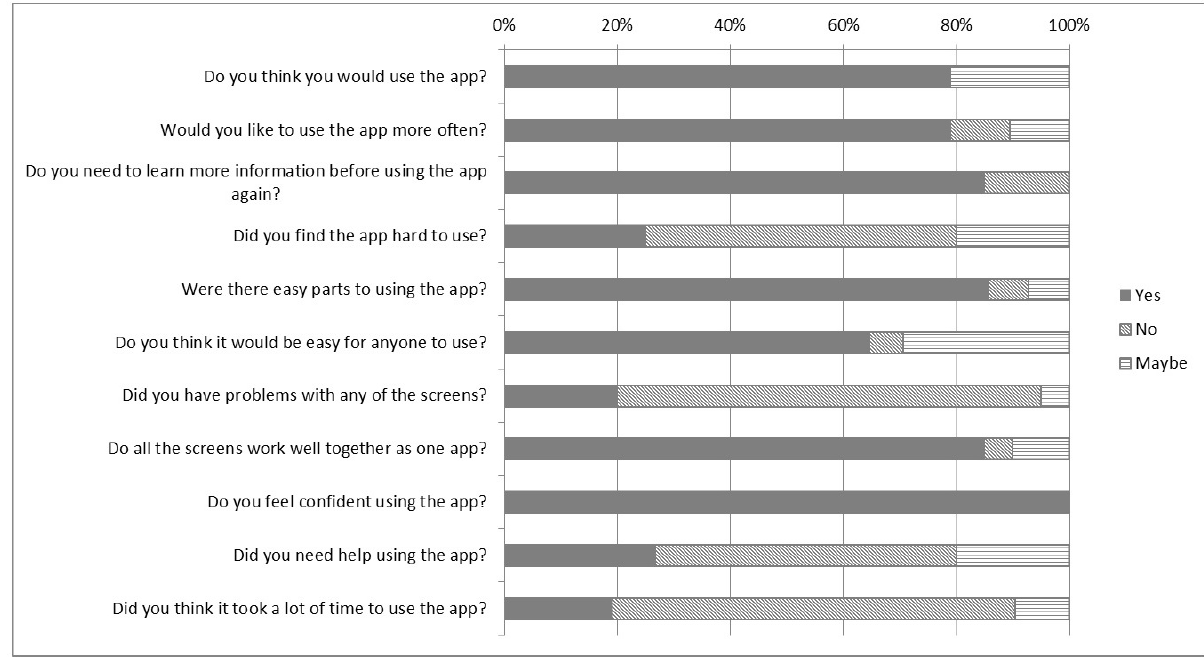
Figure 2. Responses to end-user testing interview